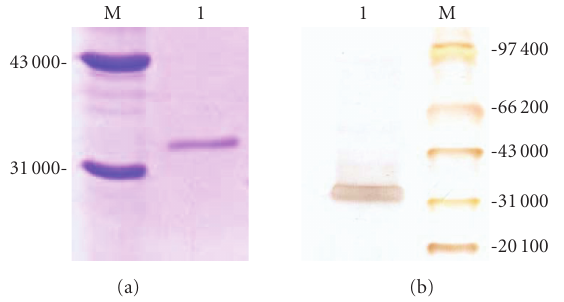
Figure 1: Purification of Ef P-III-1. Ef P-III-1 ( ∼ 34kd, lane 1) after purification was electrophoresed on a 12% SDS-PAGE. Then the gel was stained with Coomassie blue (a) or silver (b). M represents the low-molecular-mass protein markers.